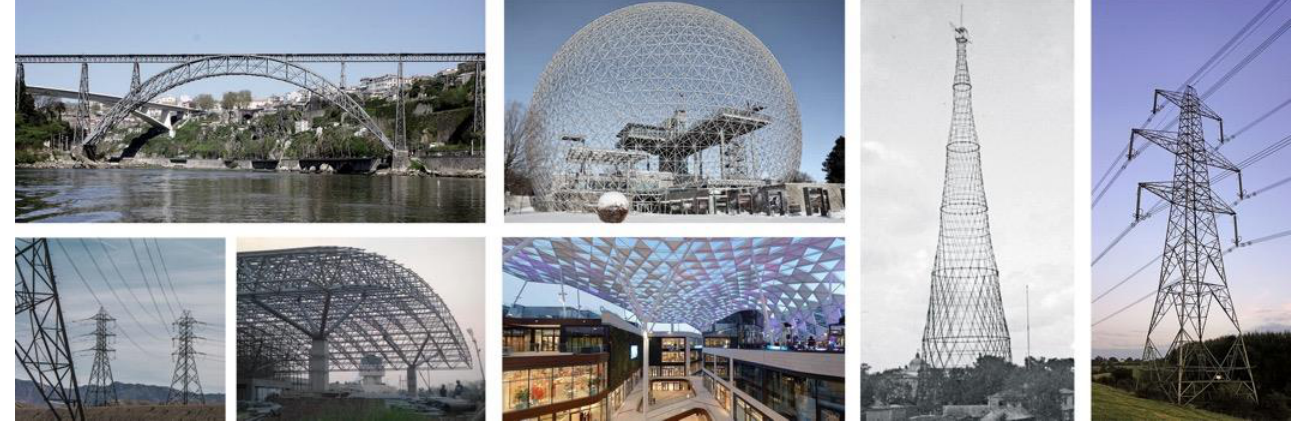
Figure 1. Examples of architectural structures based on space grid structures.